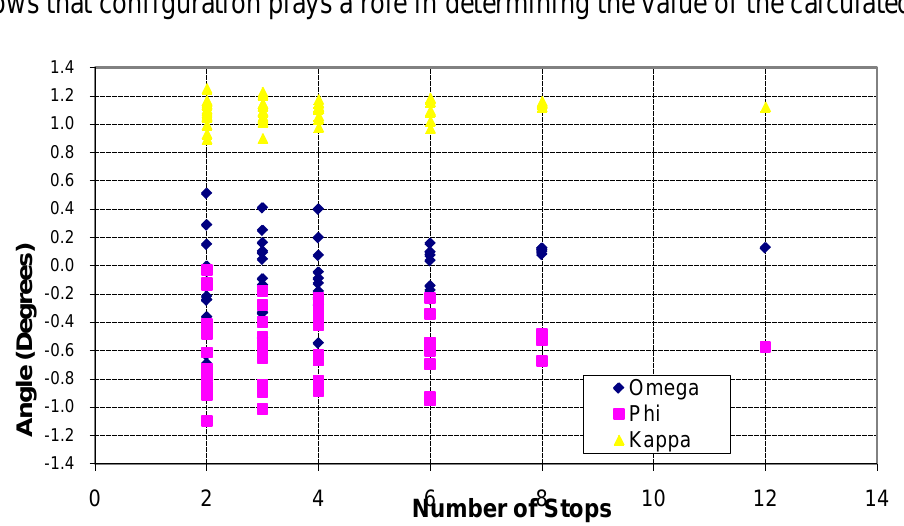
Figure 9. Field Test Results of the DAS showing values of calculated orientation angles vs. number of device stops for different symmetrical configurations of the device stops; the chart shows that configuration plays a role in determining the value of the calculated angle.